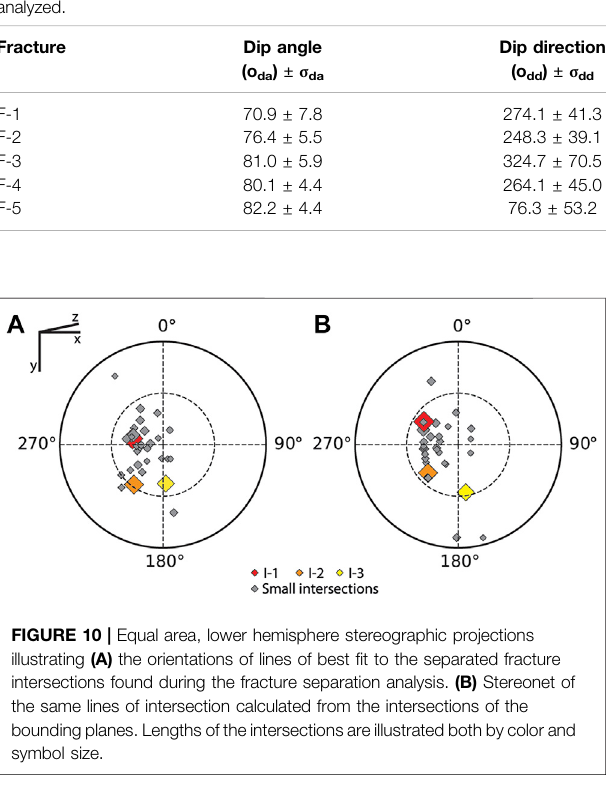
Frontiers in Earth Science |